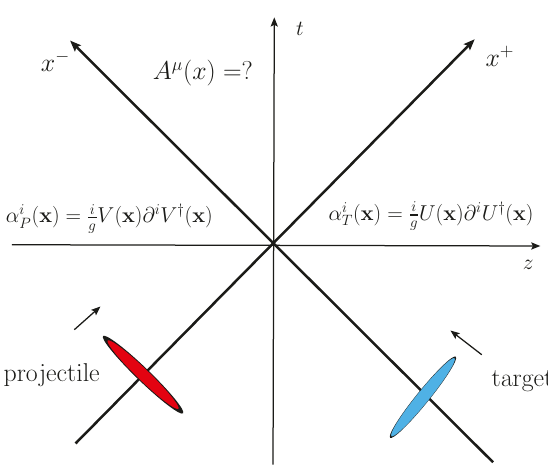
Figure 3 . Schematic diagram showing high energy nuclear collisions on the spacetime diagram. The Weizsacker-Williams fields of the projectile and targets live in the regions x − > 0 , x + < 0 and x − < 0 , x + > 0 separately before the collisions. The collisions happen at x + = x − = 0 . The goal is to find out the classical gluon fields A µ ( x ) produced in the region x + > 0 , x − > 0 after the